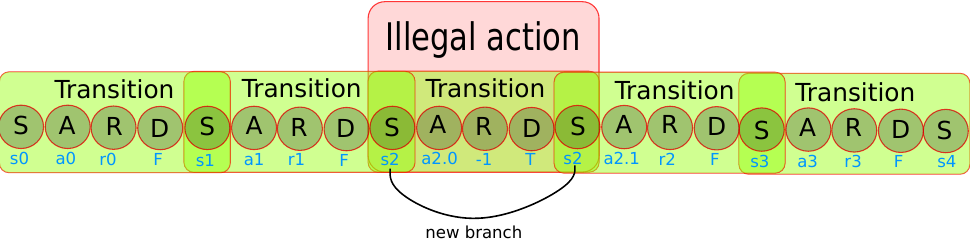
Figure 9. The structure of the PER for collision-free exploration. To save memory, every state is stored only once, linked to the next state in the trajectory. When a collision occurs, both the illegal transition ( s 2 , a 2.0 , r = − 1,done = True, s 2 ) is stored, and immediately after it, the legal transition that is actually performed in the environment, ( s 2 , a 2.1 , r 2,done = False, s 3 ) . The dummy next state s 2 in the illegal transition is irrelevant, because the transition is terminal, and the next-state Q-values are always zero.